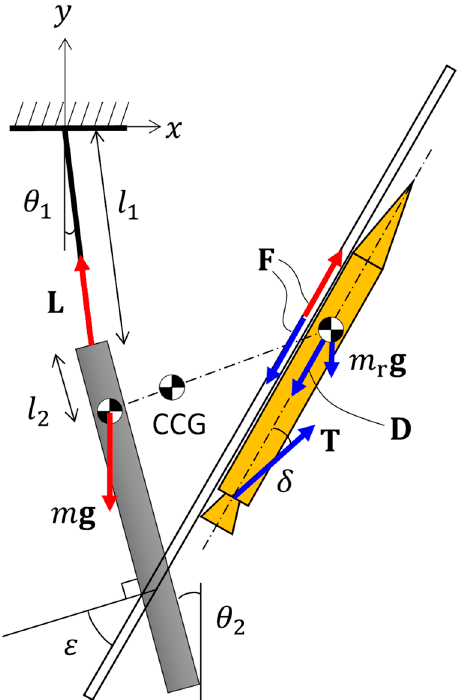
Figure 8. Double pendulum model of the suspended launcher with moving rocket. Red and blue arrows are acting on the launcher and rocket, respectively. The misalignment angle 𝛿 is highly exaggerated.